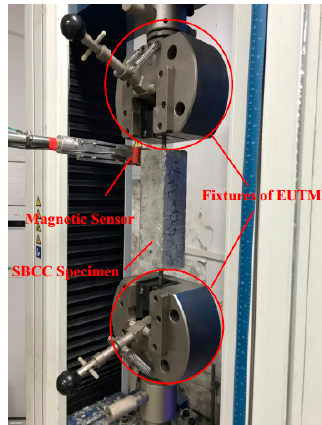
Figure 3. SBCC specimen and the electronic universal testing machine (EUTM) clamp picture.